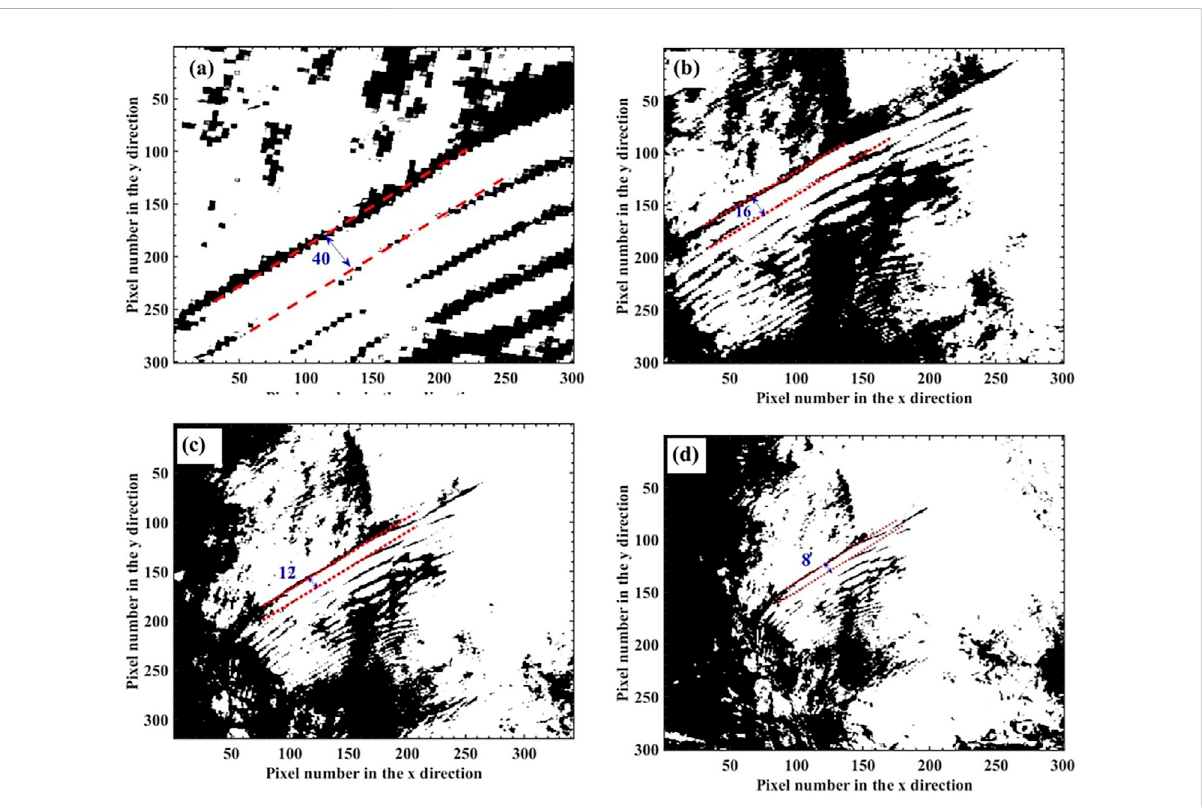
FIGURE 7 ThepeaklineandspatialwavelengthoftheinternalwaveshownFigure 6wereextracted.Thespatial wavelengthsare (A) 40pixels, (B) 16pixels, (C) 12 pixels, and (D) eight pixels.